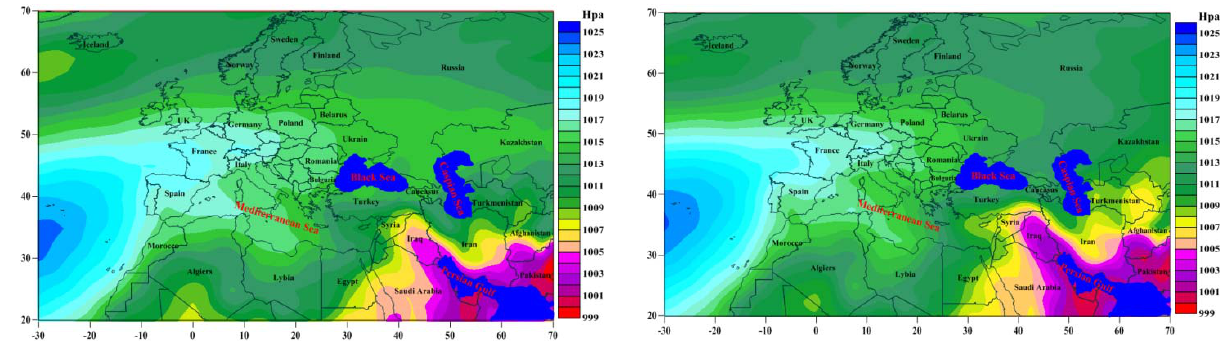
Fig. 6. Synoptic Pattern of Persian Gulf Trough Fig. 7. Synoptic Pattern of Persian Gulf Strong Trough